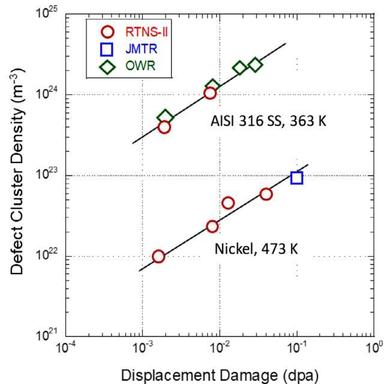
Comparison of the number density of defect clusters produced by irradiations with D-T neutrons in RTNS-II and fission neutrons in JMTR and OWR for nickel at 473 K and AISI 316 SS at 363 K .